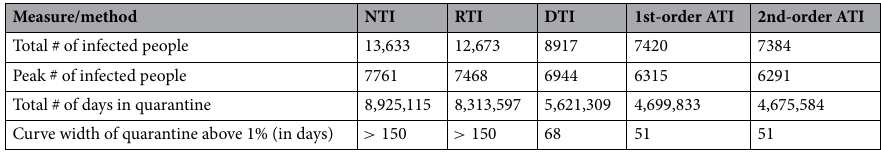
Table 3. Performance evaluation for a 85% quarantine success